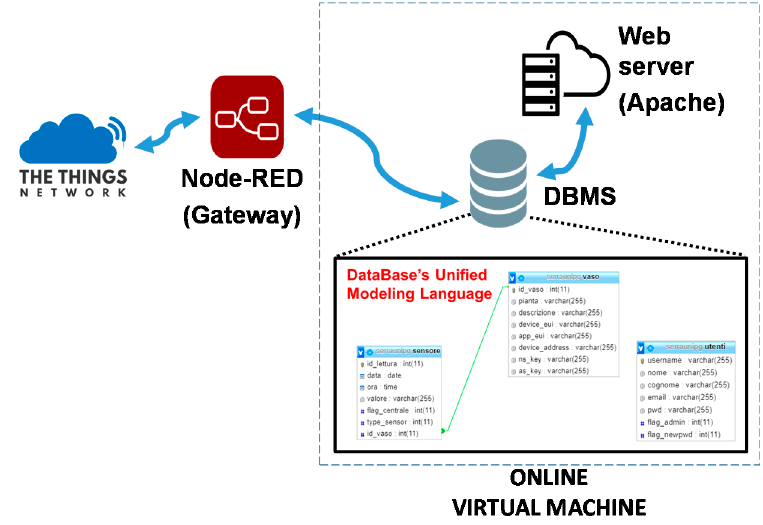
Figure 8. Block diagram of the virtual machine.